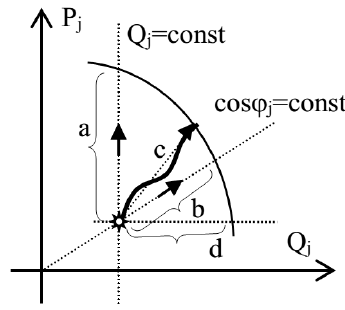
Figure 1. P - Q curve on power plane.